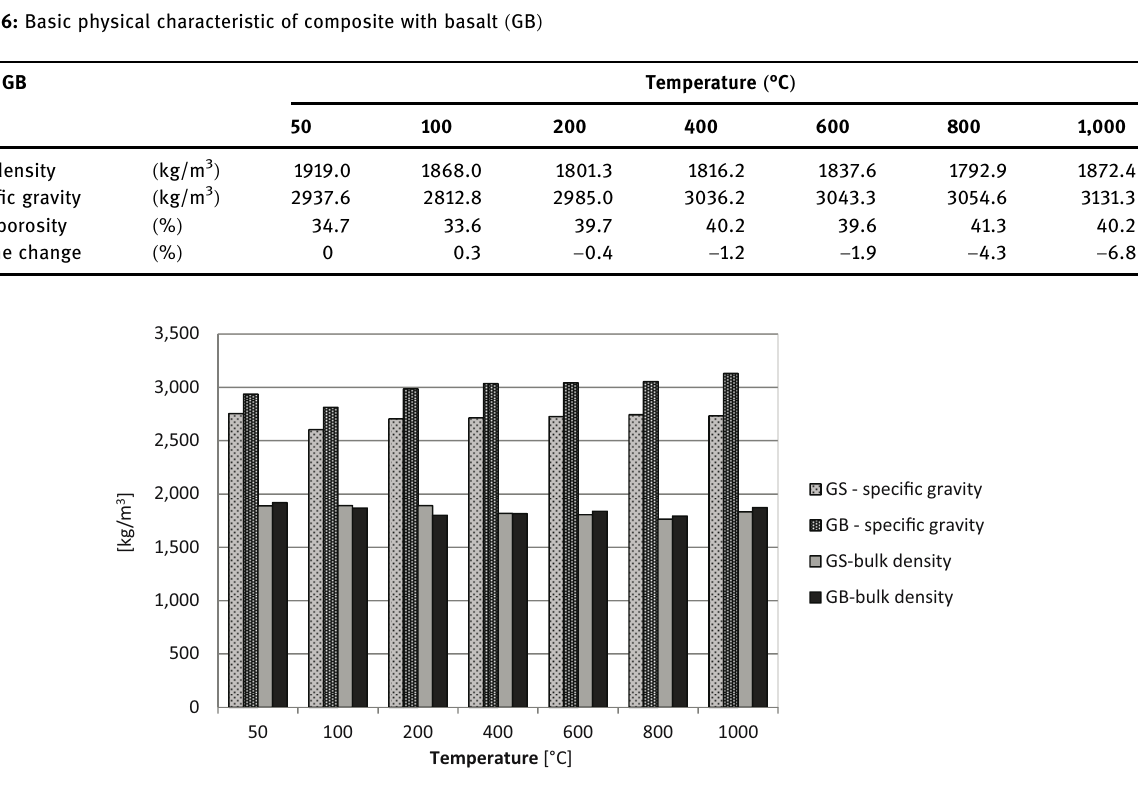
Figure 11: Speci fi c gravity and bulk density after exposition to high temperatures.